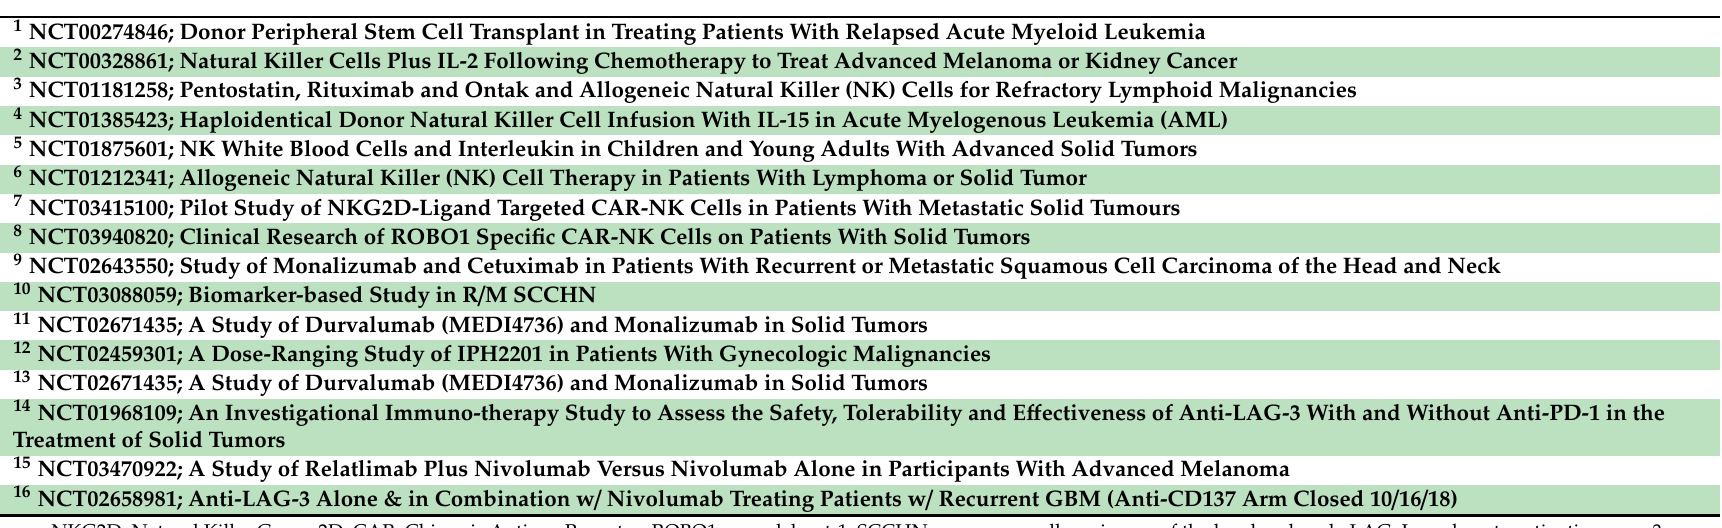
Table 1. Clinical trials